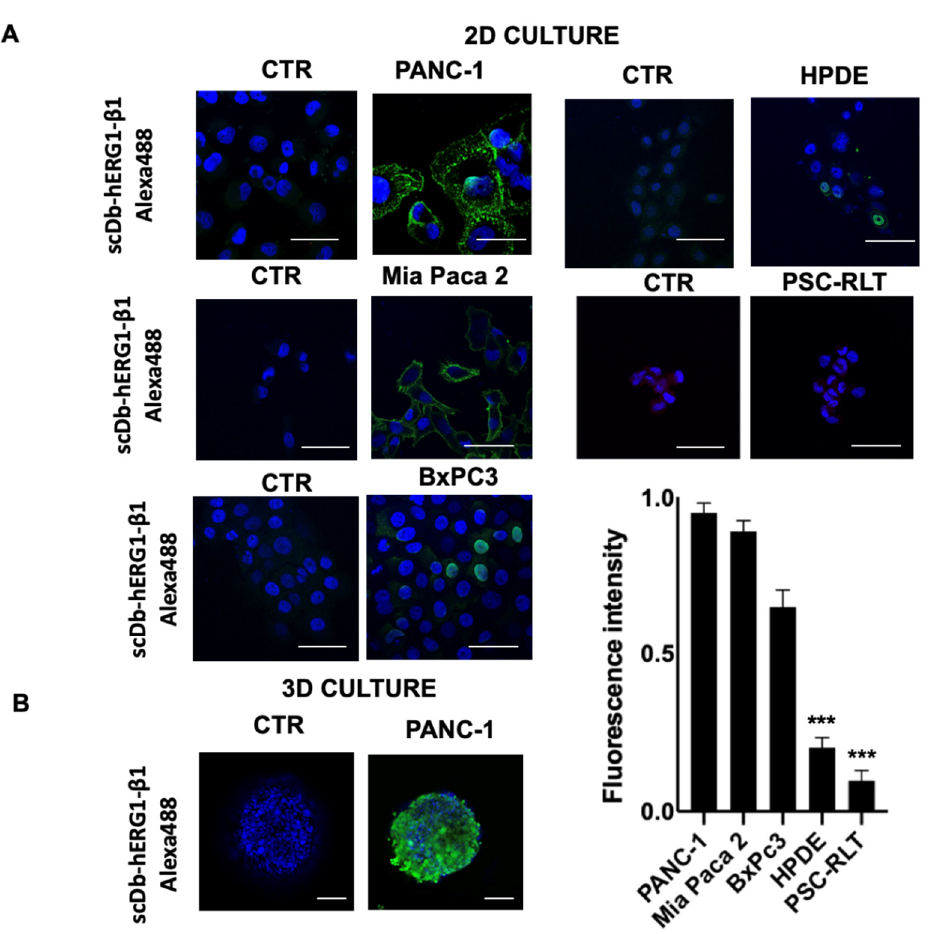
Figure 3. Expression of the hERG1- β 1 integrin complex in PDAC and normal pancreatic cells determined by immunofluorescence (IF) and relative quantification. ( A ) Direct IF on fixed PANC-1, Mia Paca2, BxPC3, HPDE and PSC-RLT cells using the scDb-hERG1- β 1-Alexa488 cultured in 2D. The picture labelled as “CTR” represents cells incubated with only the secondary antibody. Representative of three independent experiments performed in each cell line; the corresponding densitometric results are given in the bar graph on the right. p values were calculated using the Student’s t test. Scale bar = 100 µm. ( B ) Direct IF on fixed PANC-1 cells cultured as 3D using the scDb-hERG1- β 1-Alexa488. The picture labelled as “CTR” represents cells incubated with only the secondary antibody. Representative of three independent experiments. Scale bar = 50 µm. *** p < 0.001.